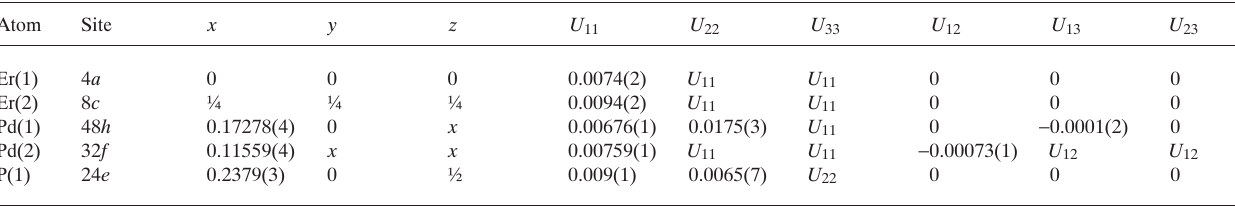
Table 2. Atomic coordinates and displacement parameters (in Å 2 )